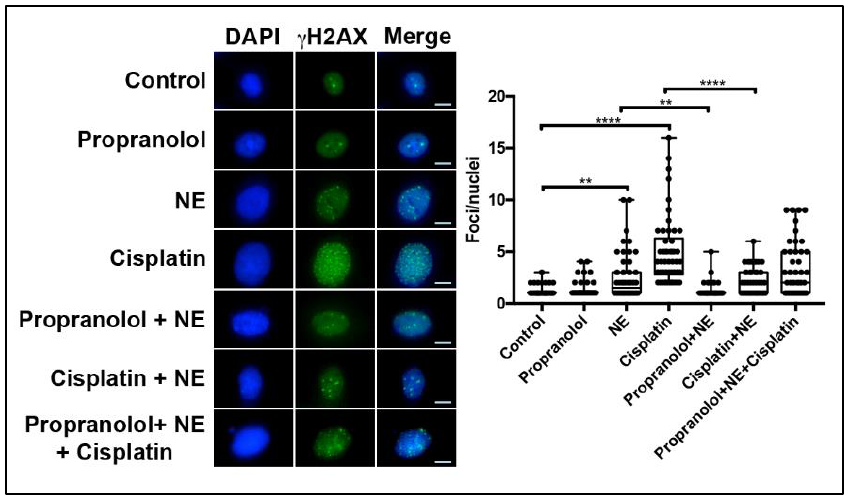
Figure 5. γ -H2AX foci formation after exposure of combination of propranolol, NE, and cisplatin in SKOV3 cells. Immunofluorescence analysis of SKOV3 cells after individual treatment with either NE, cisplatin, or propranolol, and after pre-treatment with propranolol followed by treatment of di ff erent agent combinations or left untreated (control) for 24 h. After timepoint completion, cells were fixed and immune stained for γ -H2AX and foci formation was assessed for fifty (50) cells per treatment. Statistical significance was determined by ANOVA with Dunn’s multiple comparison correction. (* p < 0.05, ** p < 0.01, **** p < 0.0001). Scale bar = 10 µ M. Images are representative of three independent